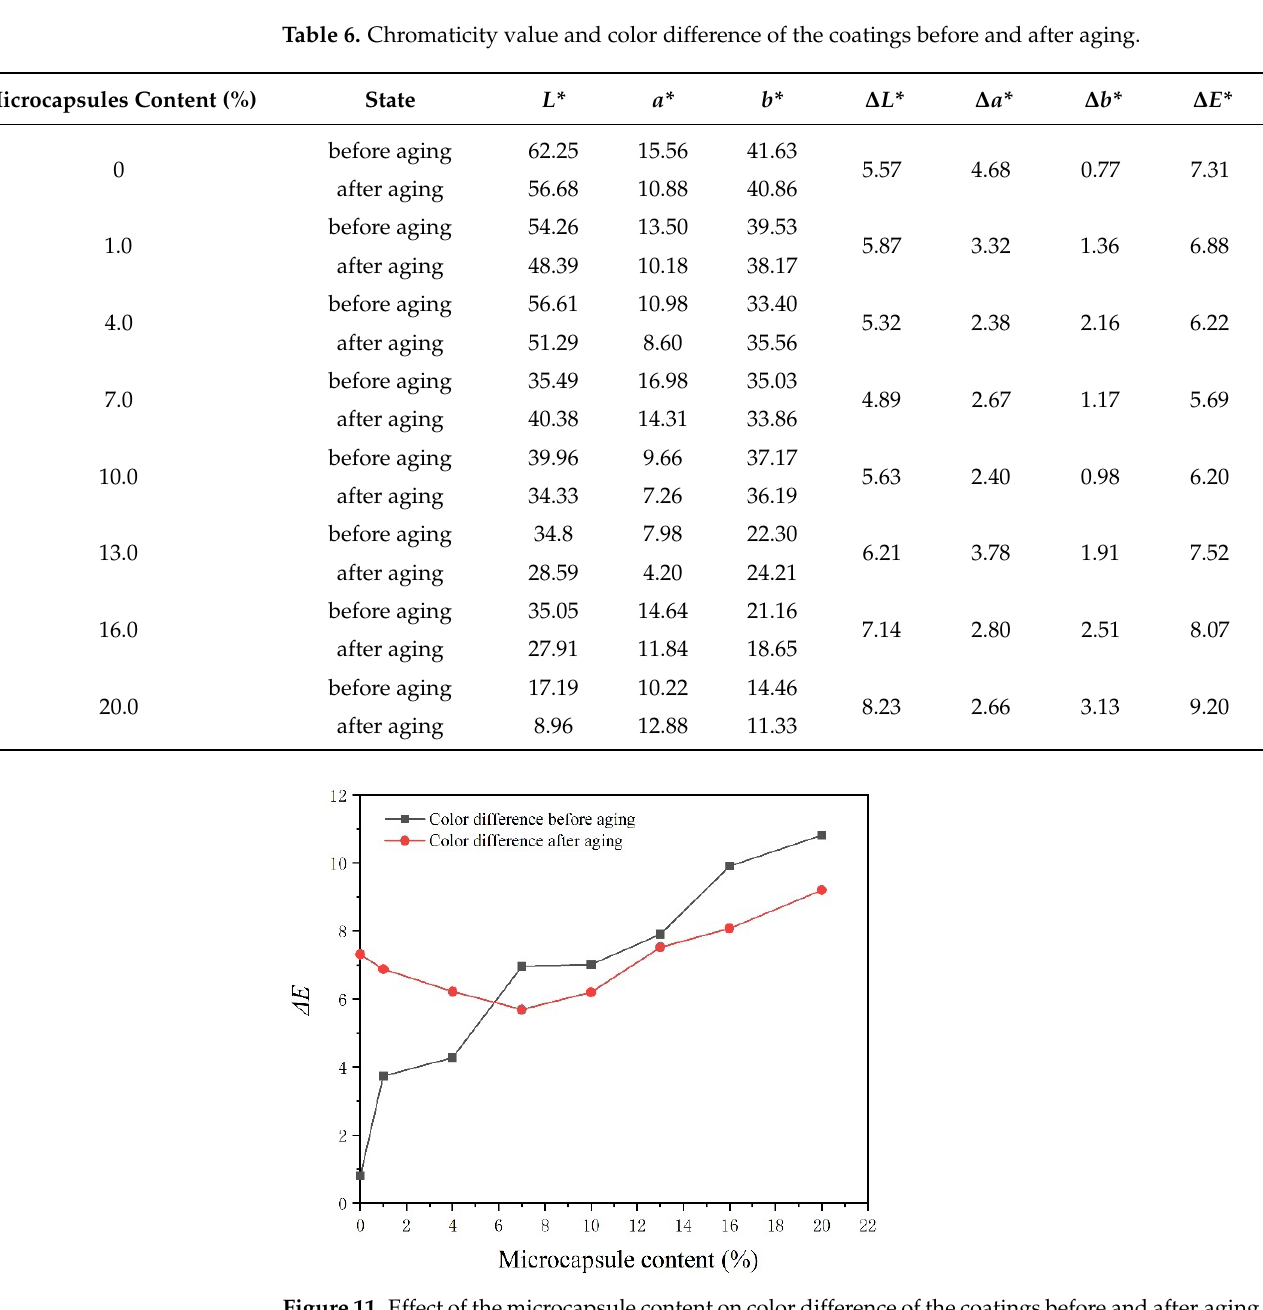
Figure 11. Effect of the microcapsule content on color difference of the coatings before and after aging.